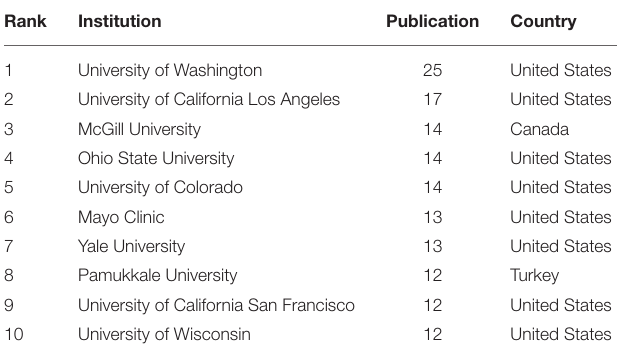
TABLE 3 | Top 10 institutions based on